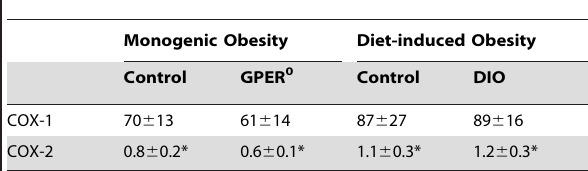
Table 2. Effect of obesity on gene expression of cyclooxygenase (COX)-1 and COX-2 isoforms in aortic perivascular